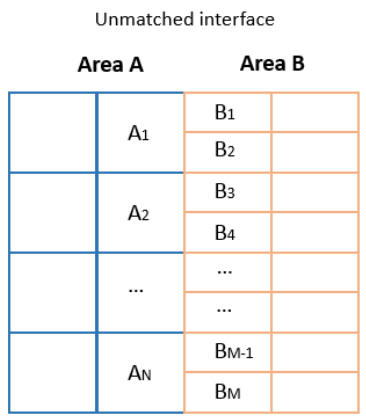
Figure 6. Schematic example of a grid with an unmatched interface.